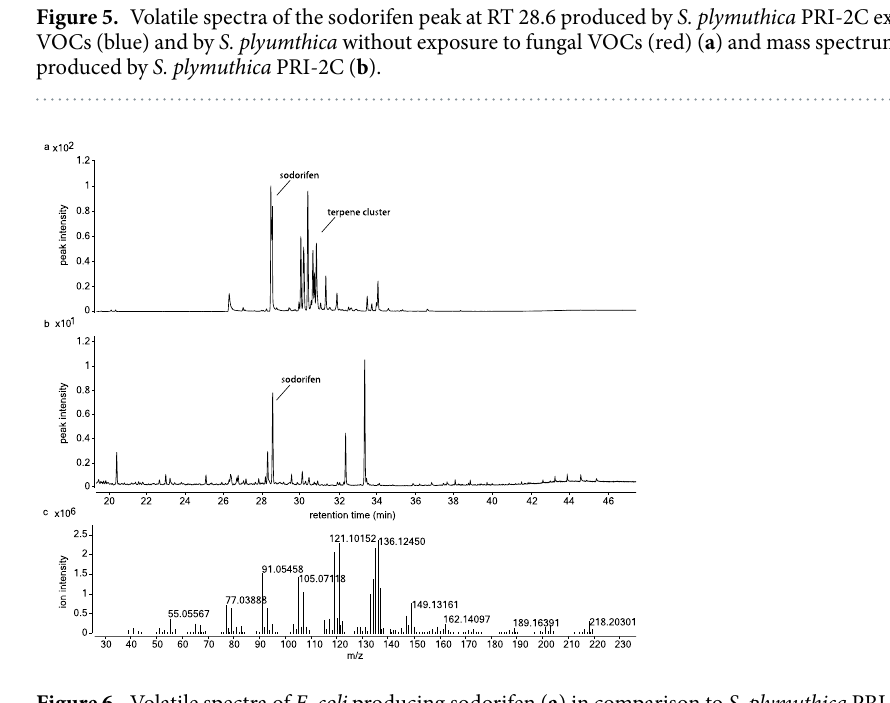
Figure 6. Volatile spectra of E. coli producing sodorifen ( a ) in comparison to S. plymuthica PRI-2C ( b ) and mass spectrum of sodorifen produced by E. coli co- expressing SpSS and SpMT ( c